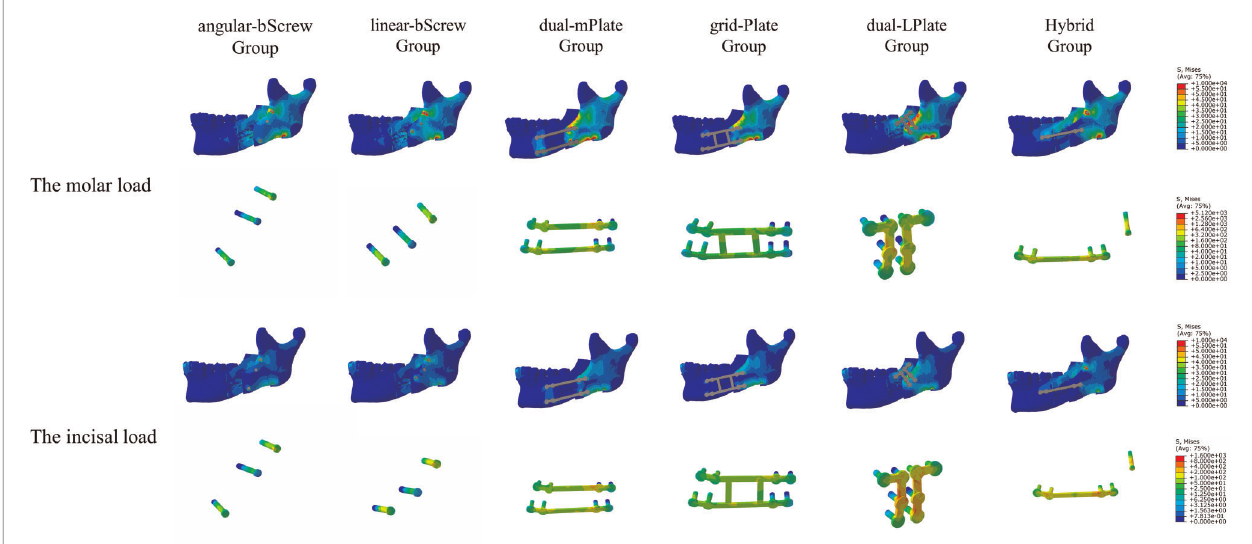
FIGURE 6 | Distribution of von Mises stress on mandibles and the von Mises stresses results for seven fi xation methods with a 15 mm advancement.